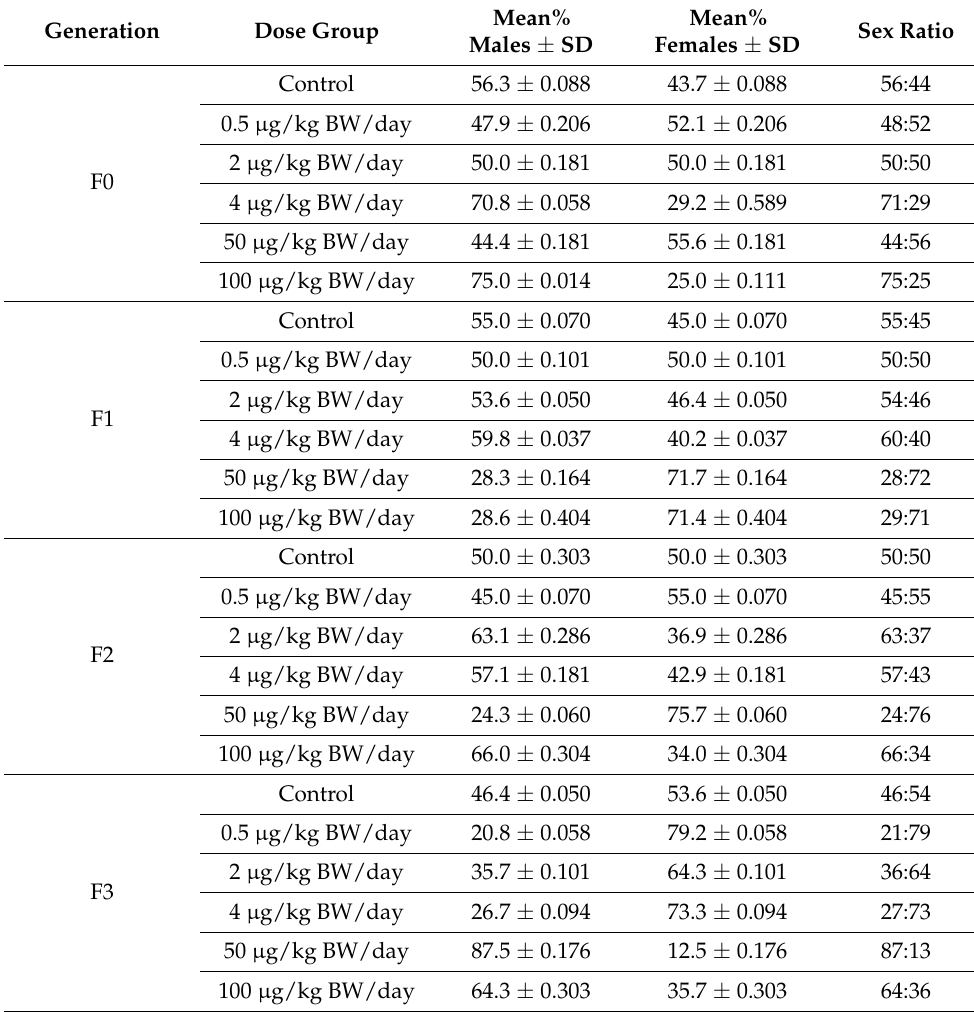
Table 3. Litters sex ratio by generation and exposure group of their parents.